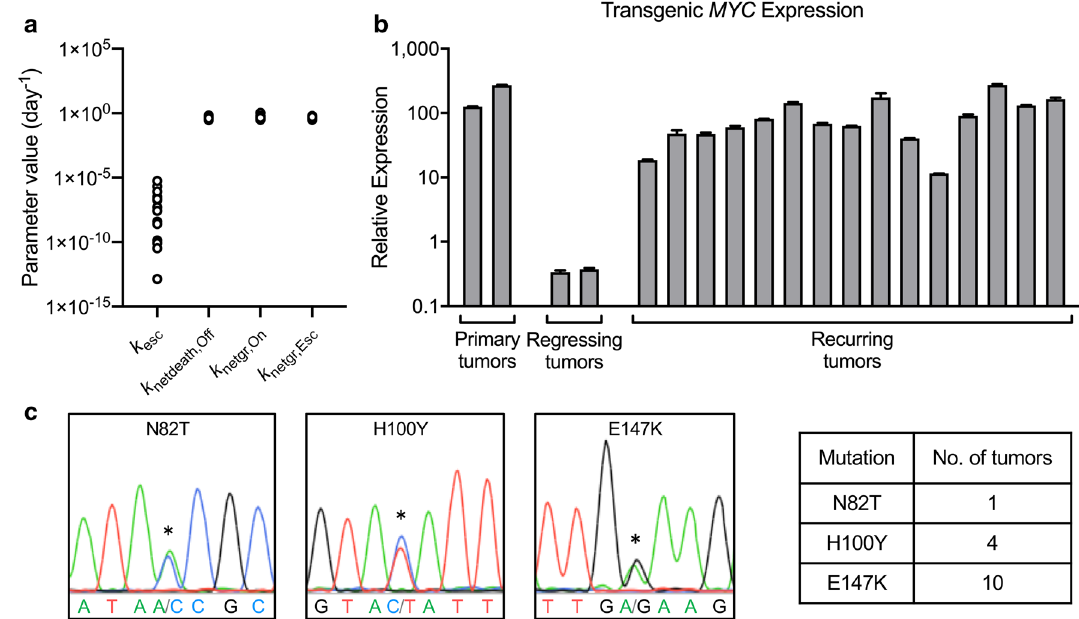
Figure 3. Quantitative analysis of tumor growth, death, and escape rates and associated tTA mutations. ( a ) Summary of parameter estimates from n = 15 mice with tumor recurrence: k esc (day −1 ), k netdeath,Off (day −1 ), k netgr,On (day −1 ), k netgr,Esc (day −1 ). ( b ) Transgenic MYC expression measured by qPCR showed that every recurring